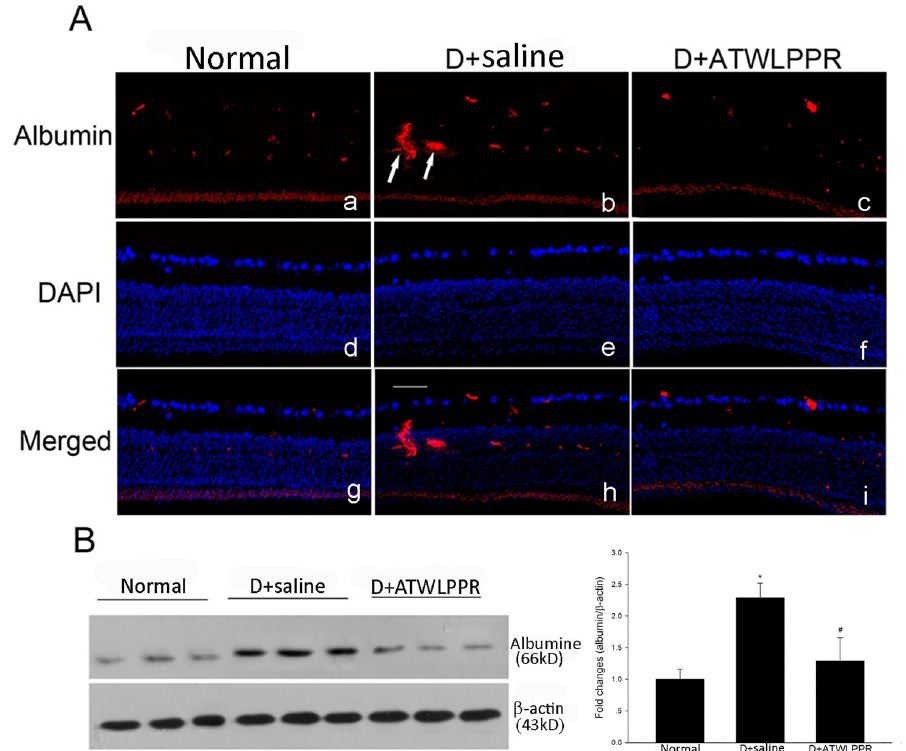
Fig 6. Extravascular albumin was inhibited by ATWLPPR in diabetic retinas. (A) Immunohistochemical staining shows the extravascular albumin (arrows) in retinal sections. Normal (a, d, g); D+saline (b, e, h); D+ATWLPPR (c, f, i). Scale bar = 50 mm. (B) Western blot analysis indicates the significant increase in leaking albumin in the D+saline retinas was suppressed by treatment with ATWLPPR. D, Diabetic. * P < 0.05, versus the Normal group; # P < 0.05, versus the D+saline